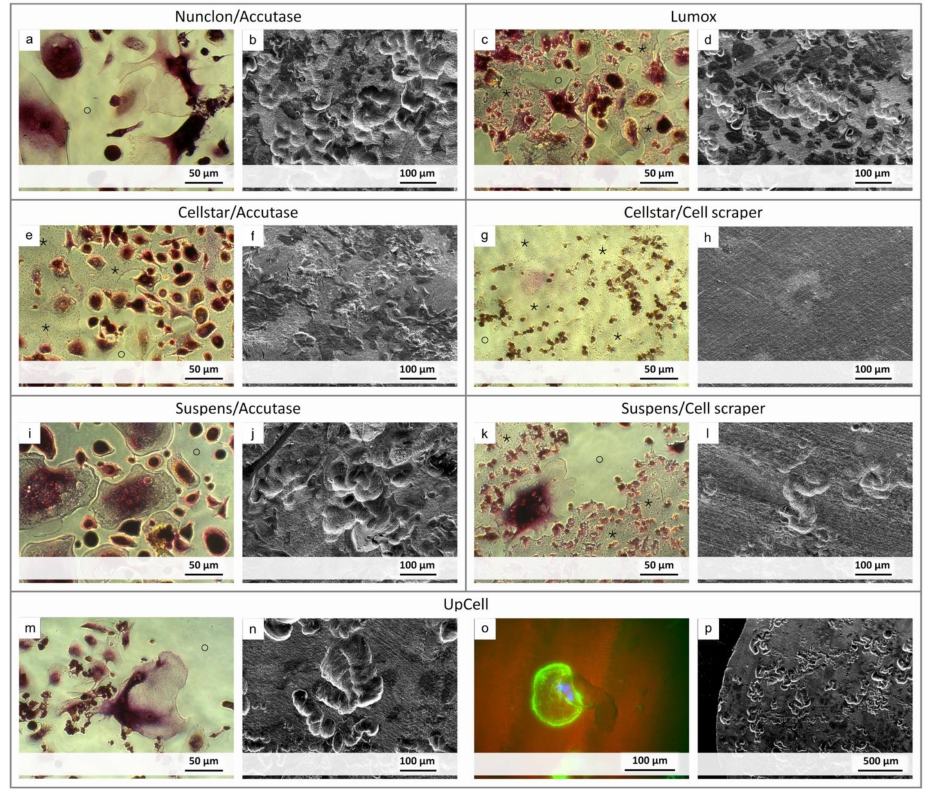
Figure 7. Images showing the resorption activity of the detached osteoclasts after reseeding. Light mi- crographs after TRAP staining of the cells show resorption (marked as o) of the decellularized osteoblast-derived matrix layer (marked as *) (( a , c , e , g , I , k , m ) for each detachment method). SEM im- ages show resorption lacunas on dentin discs (( b , d , f , h , j , l , n , p ) respectively). Special focus was put on UpCell-generated osteoclasts, where one is exemplary shown in a resorption lacuna (fluorescence image with actin skeleton shown in green and the nuclei in blue, UpCell ( o